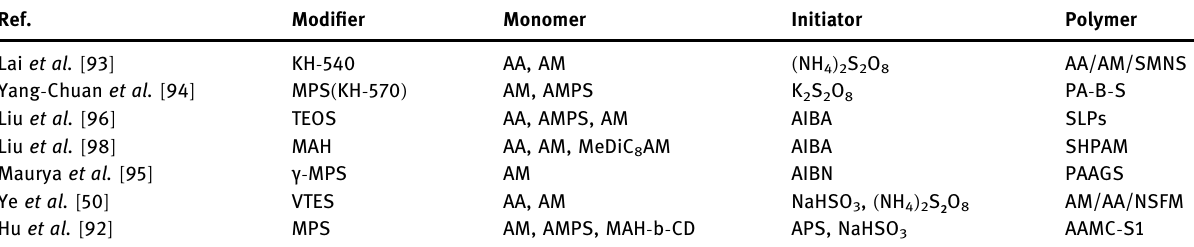
Table 2: Preparation of silicon - based polymer NFs by grafting method Ref.